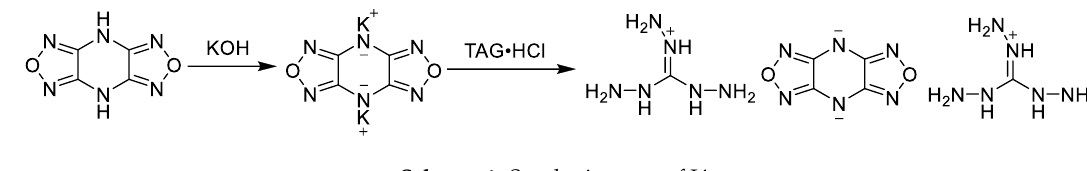
Figure 7. Comparison of ∆ G rxn of ammonium-based 4,8-dihydrodifurazano[3,4- b , e ]pyrazine-based salts. 2.6. Synthesis of Triaminoguanidinium Table 1. Predicted densities ( ρ ), heats of formation ( Δ H f ), heats of detonation ( Q ), detonation velocities ( D ), detonation pressures ( P ), oxygen balance (OB), impact sensitivity ( H 50 ) and Gibbs free energies of formation (Δ G rxn ) of ammonium-based 4,8-dihydrodifurazano[3,4- b , e ]pyrazine-based salts.